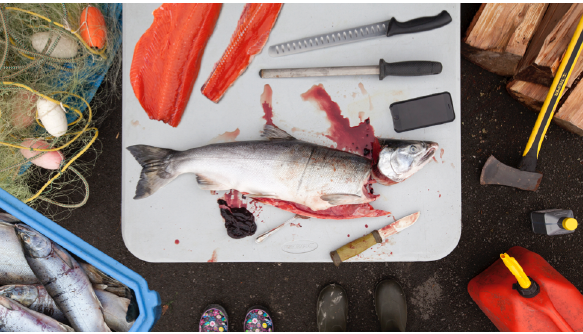
Figure 5 | The fish-cutting table top view. Courtesy Reese Muntean.